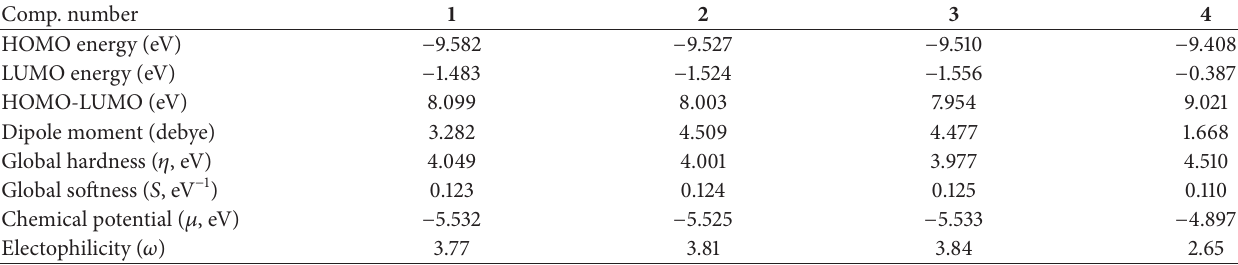
Table 9: Computed molecular descriptors of complexes 1–4